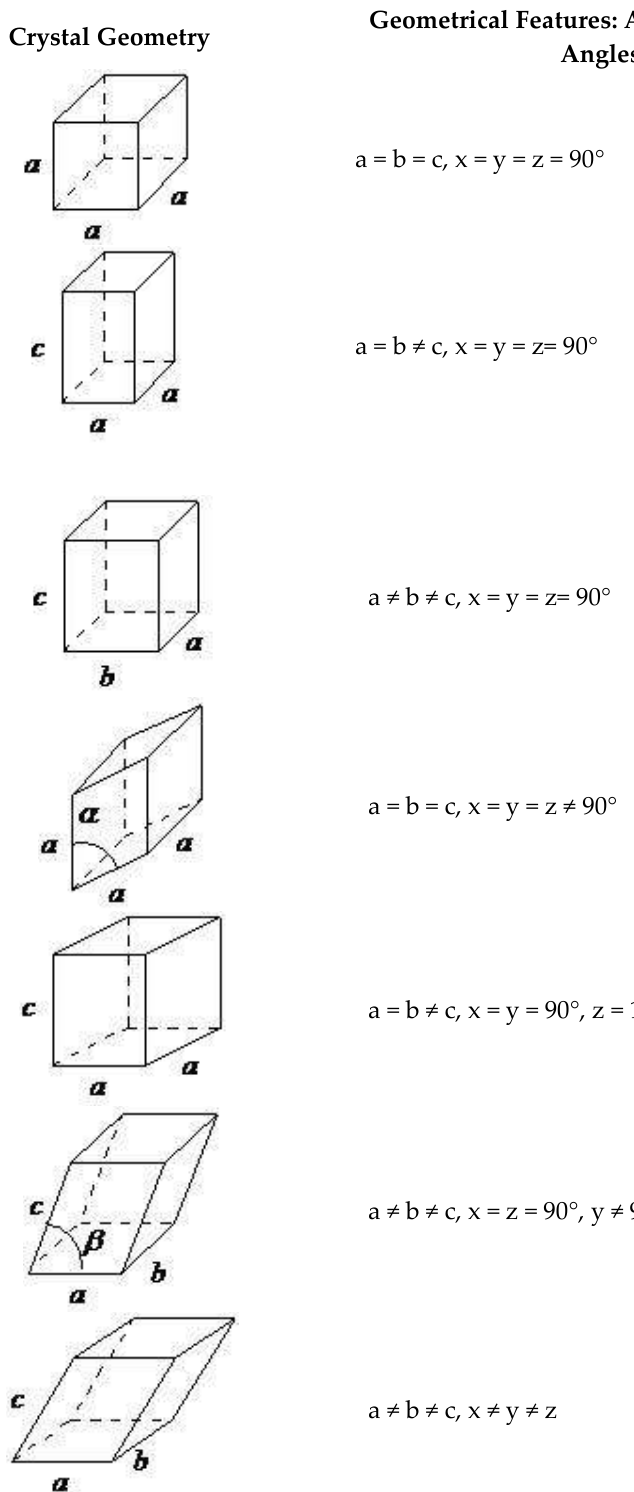
Figure 2. Geometrical features: axial lengths and angles of crystal structures.